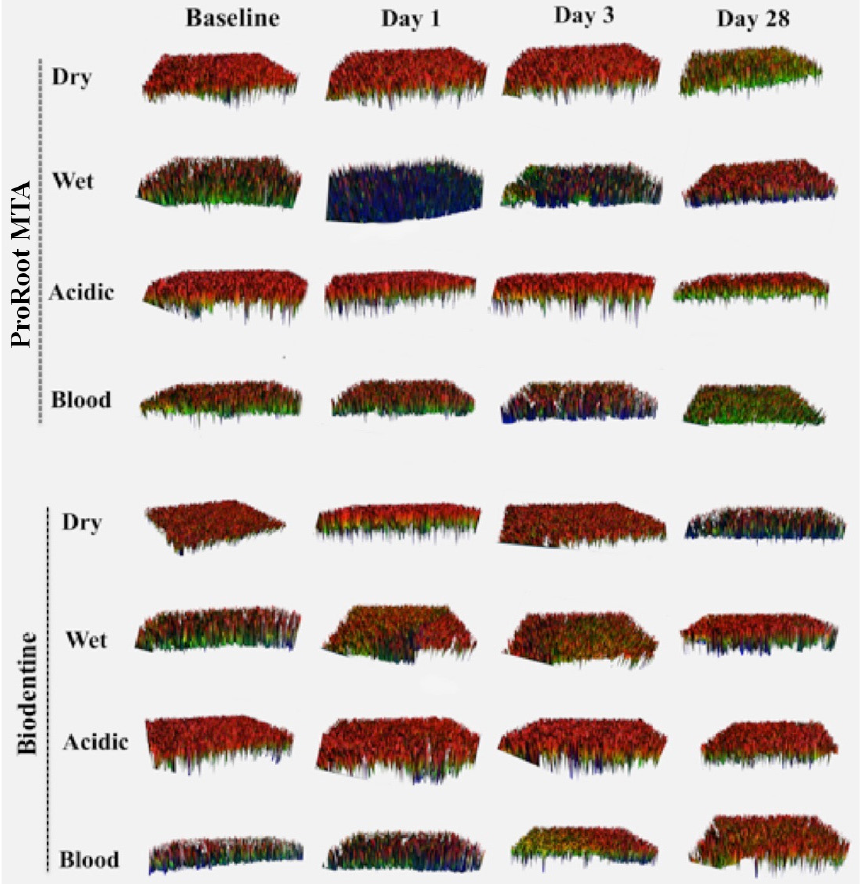
Figure 2- Representative 3D images obtained using an optical profilometer showing surface topographies of ProRoot MTA and Biodentine at different environmental conditions over time. The color change from red to blue indicates a surface change from increased to decreased roughness. 3D surface images show that the surface roughness of both materials decreased in dry conditions after 28 days. In wet conditions, the surface roughness of ProRoot MTA decreased on the 1 st day; however, roughness increased for up to 28 days for both materials. In acidic conditions, the surface roughness of both materials was similar at all time points. In blood conditions, the surface roughness of both materials decreased gradually after the 1 st